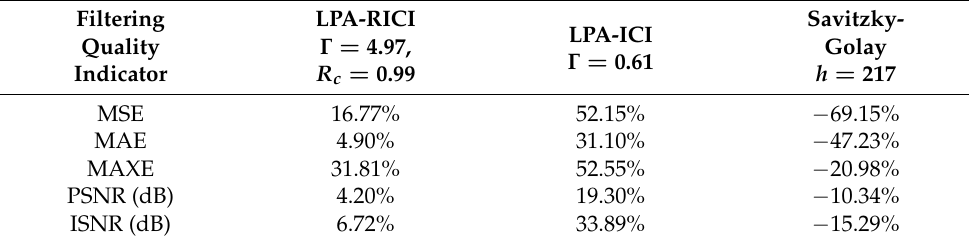
Table 25. HeaviSine signal (SNR = 5 dB)—Filtering quality improvement of the RBF-RICI-based filtering over other tested algorithms.